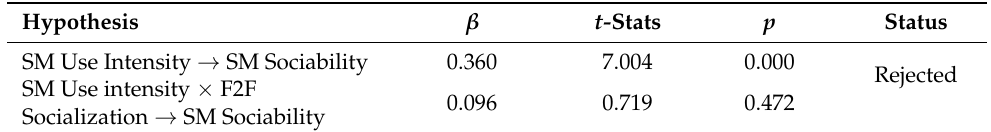
Table 10. The moderating effect.